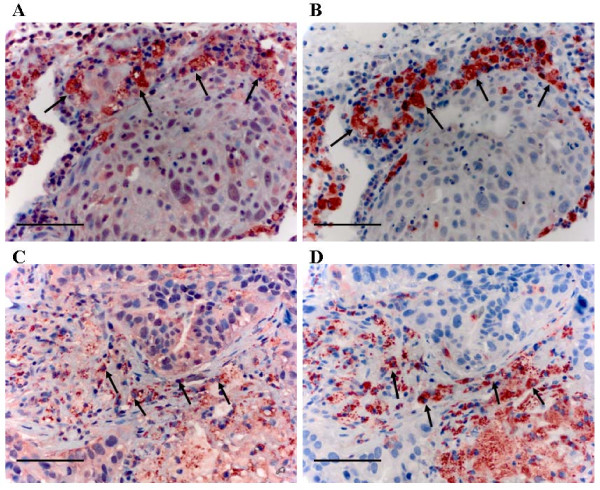
Immunohistochemical expression of IL-10, cathepsin B and CD68 in macrophage. A-B, High IL-10 expression in macrophage, A, IL-10 staining in macrophage (strong positivity); B, CD68 staining. C-D, Cathepsin B expression in macrophage; C, cathepsin B staining in macrophage (most cells were moderate positivity, only a few cells were strong staining); D, CD68 staining. Scale bar indicates 50 μm. Original magnification, × 400.